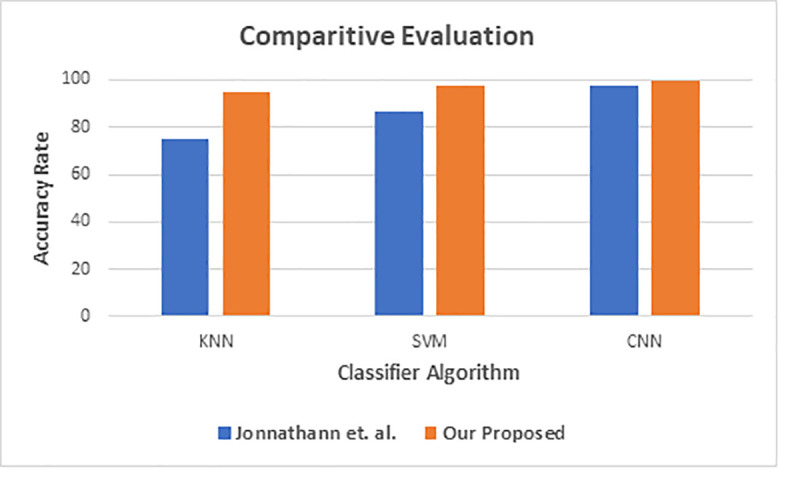
Comparative evaluation of the proposed FR system vs recent literature.